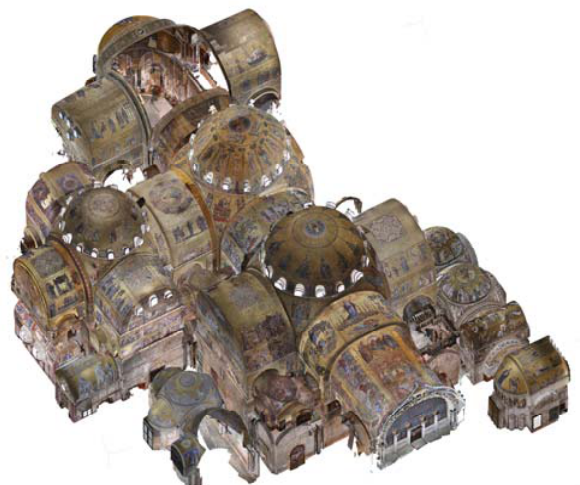
Figure 4: Merging of all calculated point clouds of the interior of the